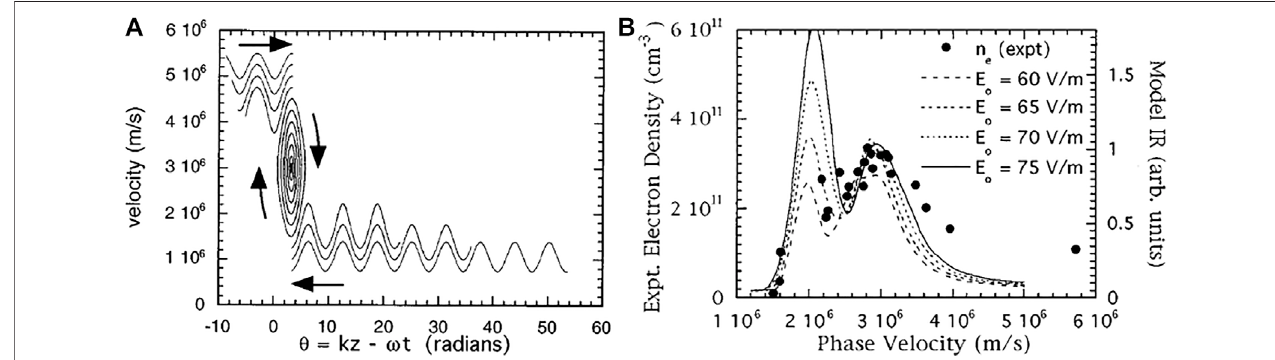
FIGURE 1 | Illustration of the interaction between electrons and helicon wave in phase space (A) and comparison between numerical and experimental electron densities (B) . Reproduced from [15], with the permission of AIP Publishing.